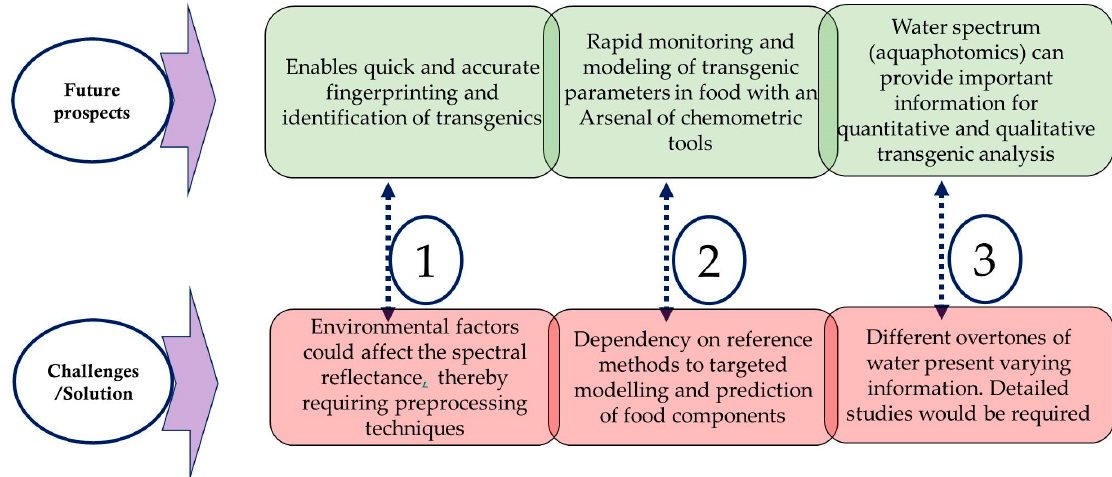
Figure 4. Major future prospects and challenges of NIRS for transgenic food analysis.